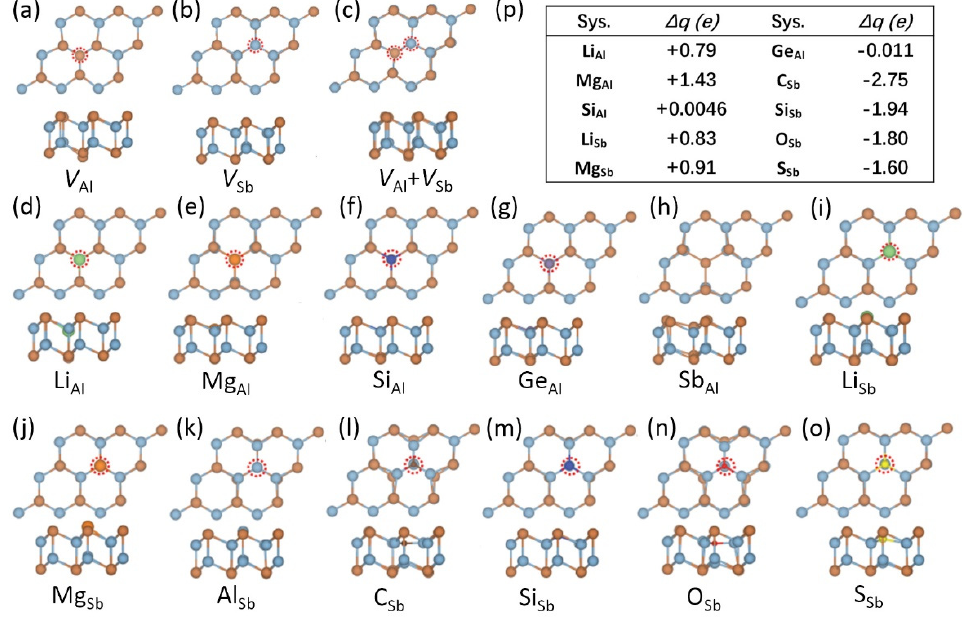
Figure 6. Atomic structures of DLHC AlSb with vacancy and substitutional defects: ( a ) V Al , ( b ) V Sb , ( c ) V Al + V Sb , ( d ) Li Al , ( e ) Mg Al , ( f ) Si Al , ( g ) Ge Al , ( h ) Sb Al , ( i ) Li Sb , ( j ) Mg Sb , ( k ) Al Sb , ( l ) C Sb , ( m ) Si Sb , ( n ) O Sb and ( o ) S Sb . ( p ) Charge transfer ( ∆ q) of these defects, where the positive (negative) values indi- cate defect tends to lose (gain) charge. Reproduced with permission [49]. Copyright 2021, IOP Pub- lishing.